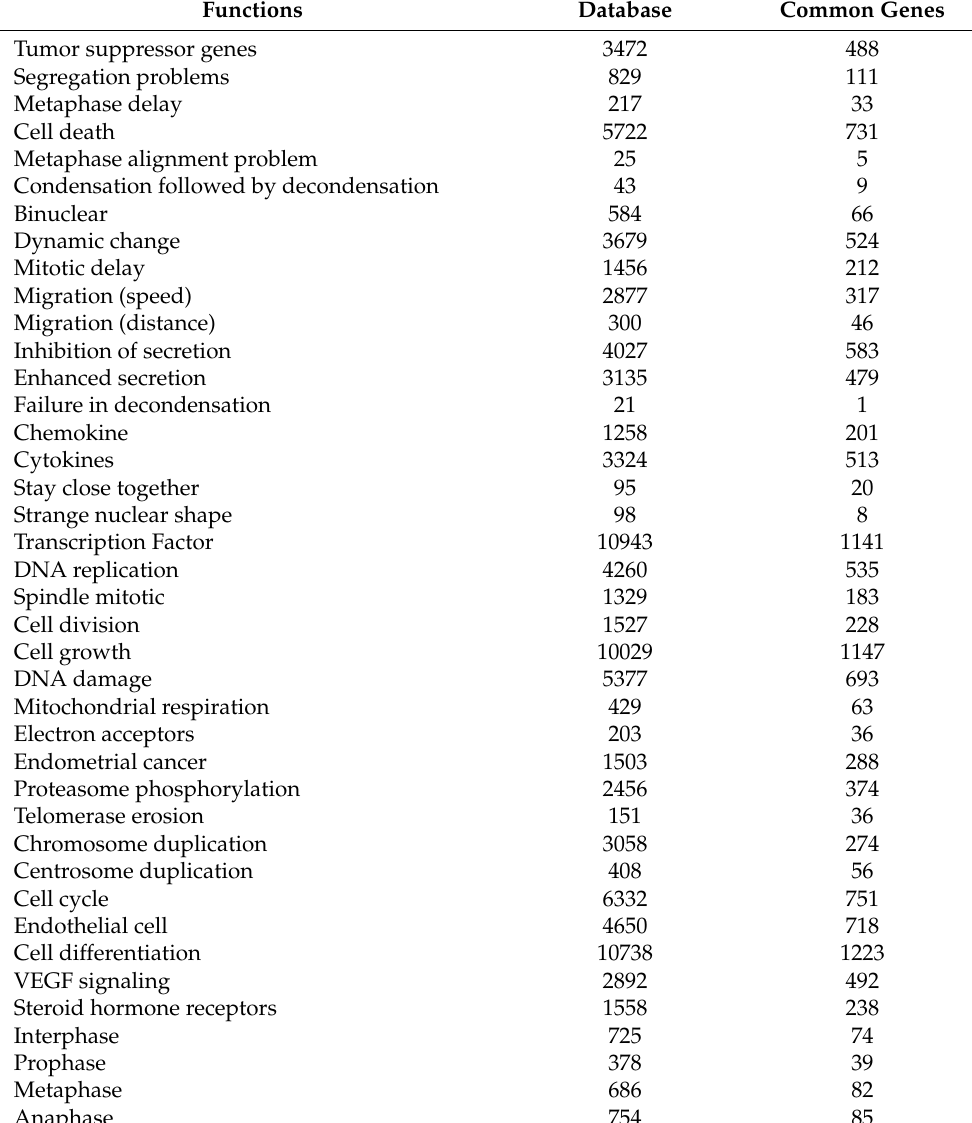
Detected functions of the common genes involved in cell cycles using the GeneCards